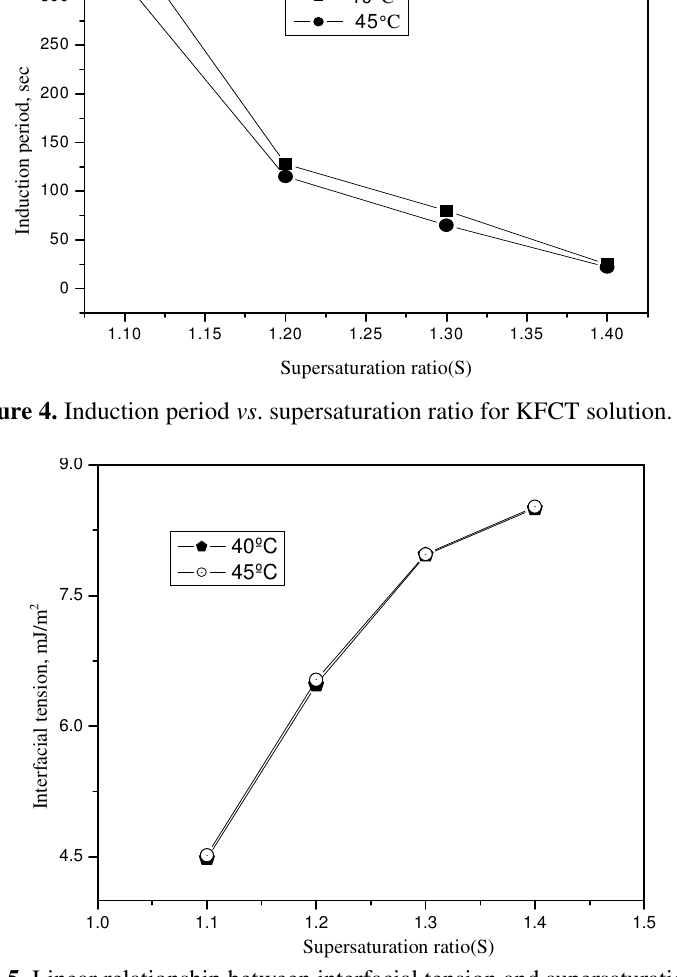
Figure 5 . Linear relationship between interfacial tension and supersaturation. Table 2 . Nucleation parameters of the